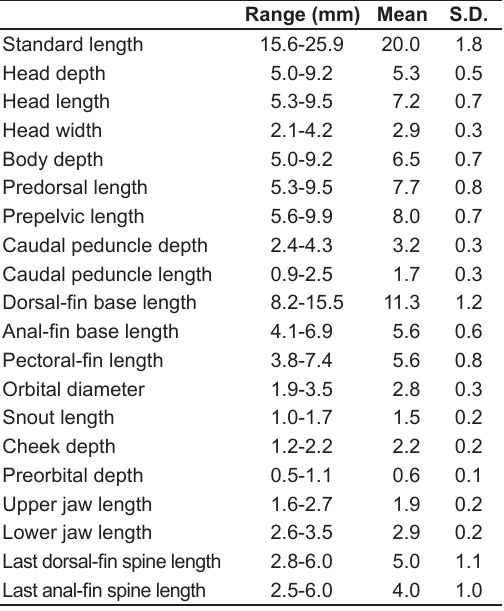
Table 1. Morphometry of 50 specimens of Apistogrammoides pucallpaensis , including sample range, mean and standard deviation (S.D.).